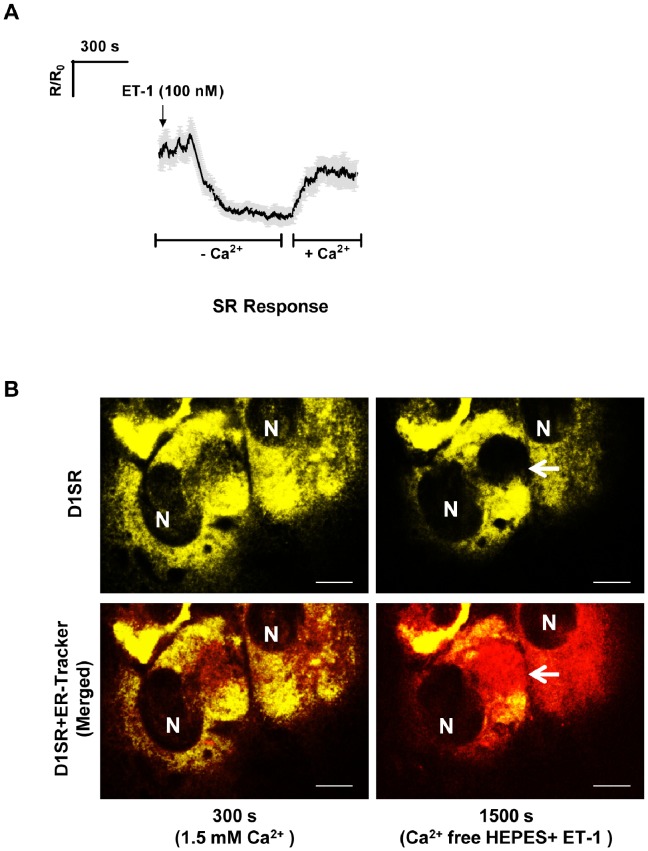
Refilling of SR Ca2+ and maintenance of SR structure following the depletion wave.
A) The SR is refilled by subsequent re-perfusion of the cell culture with normal (1.5 mM) Ca2+ solution following depletion wave progression, confirming the reversibility of Ca2+ depletion wave. B) Live snapshots of overlay of D1SR and ER-Tracker signals in cultured SMCs showing that the SR luminal structure remains intact during and after the progression of ET-induced Ca2+ deletion wave (marked by white arrows) and in the absence of extracellular Ca2+. (scale bars, 15 µm).